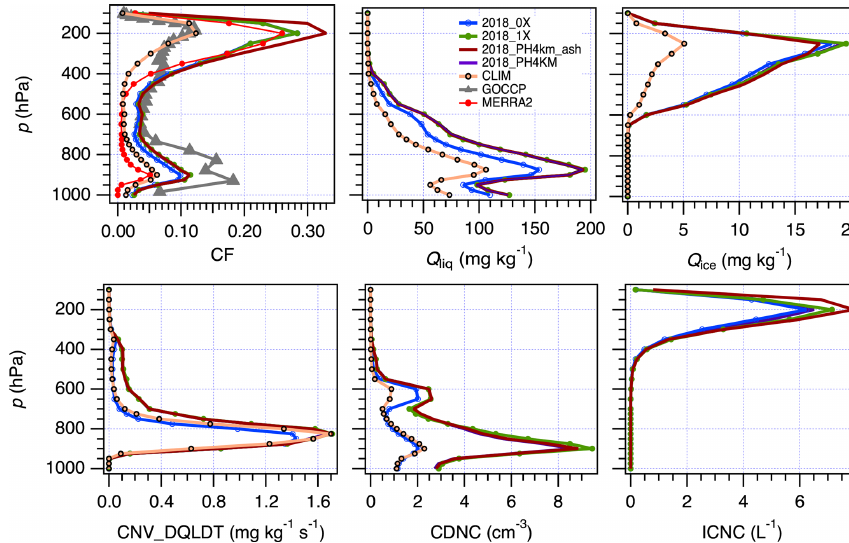
Figure 11. Equivalent to Fig. 10 but for the 2018 MJJ